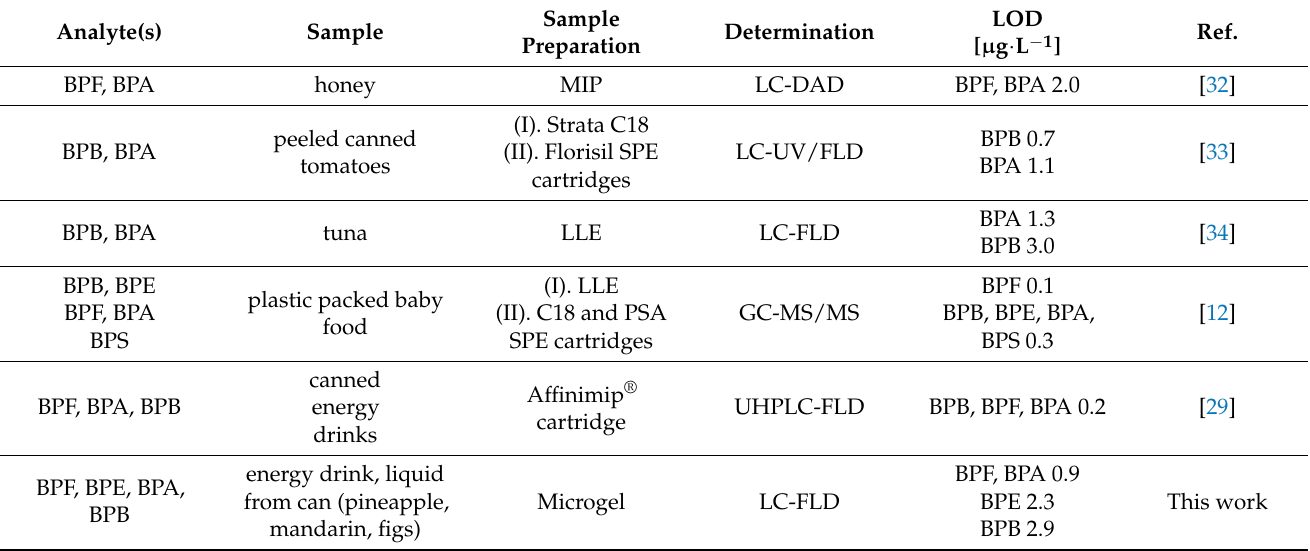
Table 4. Comparison of our method of preconcentration of bisphenols to others.